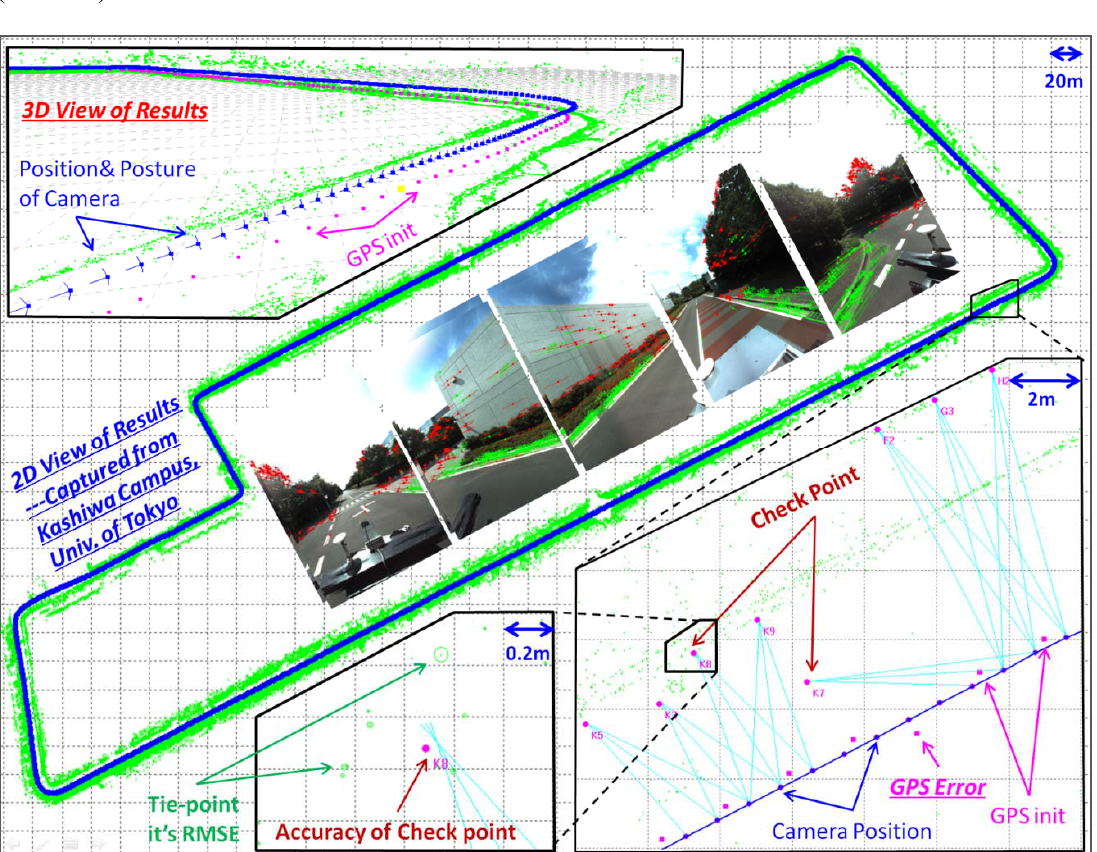
Figure 1. An overview of the results of our proposed method. The blue line in the middle represents the trajectory through the Kashiwa campus of the University of Tokyo, and the nearby green circles are the tie-points. The separate images in the route are from the 5 mono-lenses. Green dots indicate correctly matched tie-points with good distributions, and red dots indicate mismatched points that have been excluded from the error detection steps. A 3D view of the results is shown in the top left corner; blue dots represent the position and posture after SLAM, and pink dots represent the GPS route. The two boxes in the bottom right are the zoomed area in which the GCPs are included. The light green corresponding rays intersect correctly in the right box, and the RMSE of the tie-points and check points both reach an accuracy of several centimetres with a grid scale of 0.2 m (left